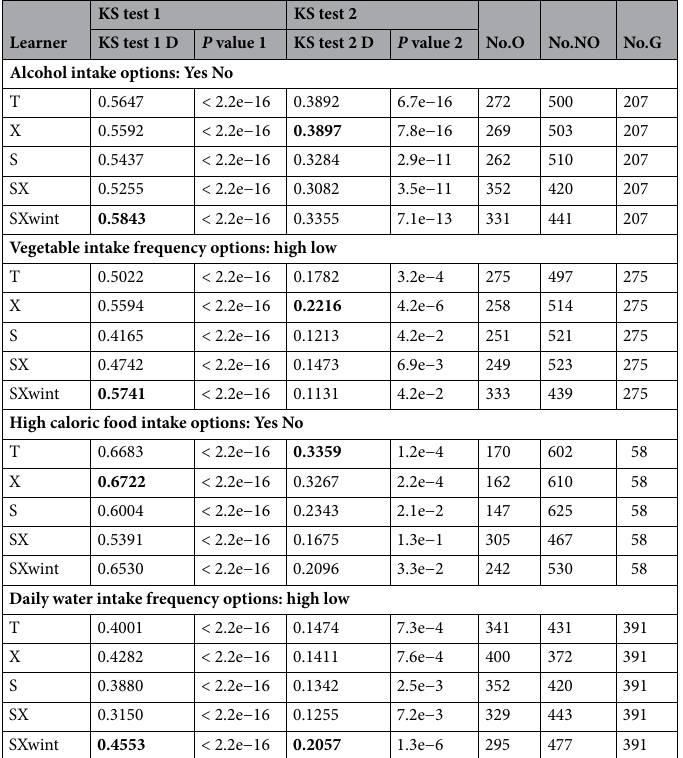
Table 2. Two-sample Kolmogorov–Smirnov (KS) test results concerning alcohol, vegetable, high caloric food and daily water intake. KS Test 1 D and P Value 1 are the test statistic and p value of KS test 1 between the distributions of BMI in personalized optimal and non-optimal groups. KS Test 2 D and P Value 2 are the test statistic and p value of KS test 2 between the distributions of BMI in personalized optimal and general optimal groups. No. O is the sample size of personalized optimal group. No. NO is the sample size of non-optimal group. No.G is the sample size of general optimal group. The largest KS test distance statistic produced under each type of food or drink is in